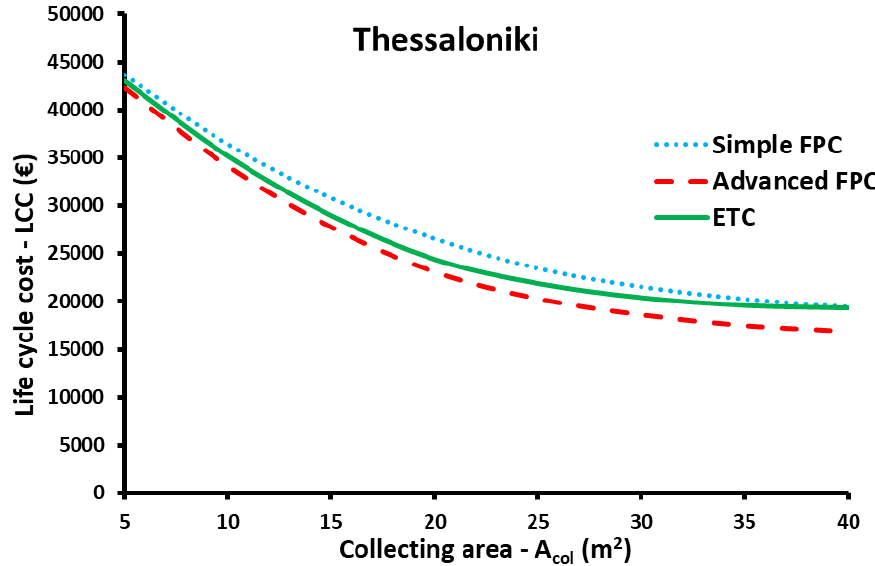
Figure 21. Life cycle cost for different collecting areas and collector types for Thessaloniki.